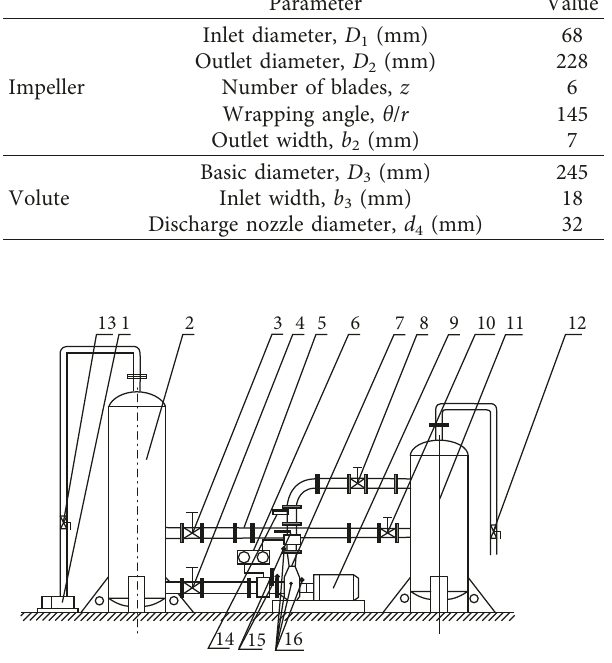
Figure 2: Schematic of test rig: (1) vacuum pump; (2) cavitation tank; (3, 4, 8, 10) brake valves; (5) electromagnetic flowmeter; (6) pressure transducers; (7) model pump; (9) variable-frequency motor; (11) pressure stabilizer; (12, 13) ball valve; (14)